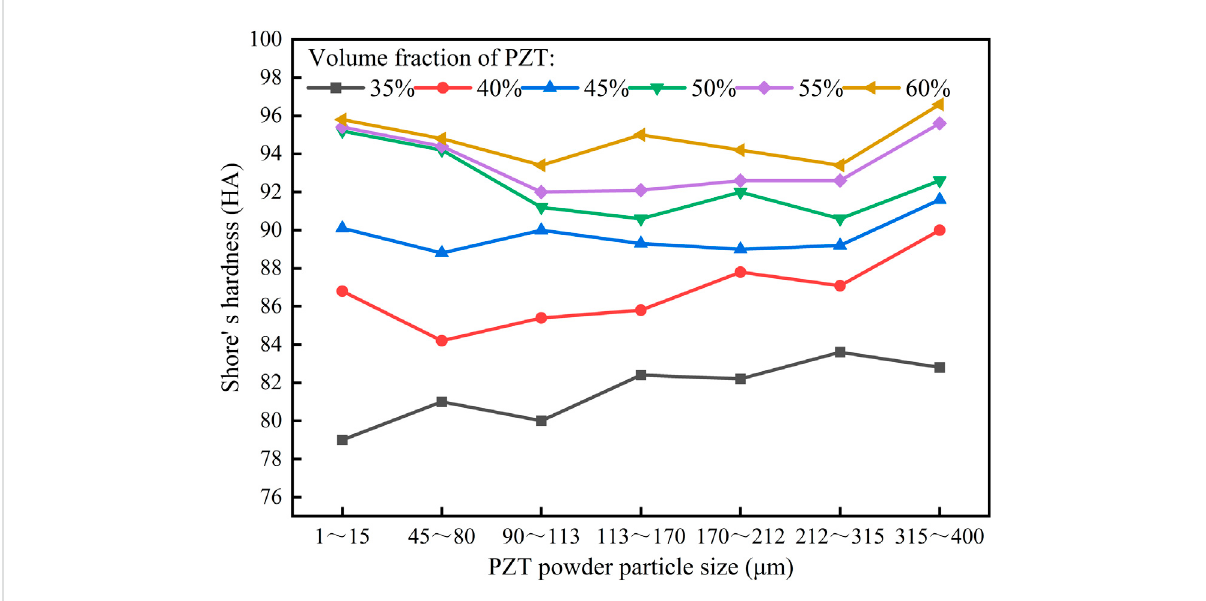
FIGURE 15 Variation of composite Shore hardness with PZT volume fraction and powder